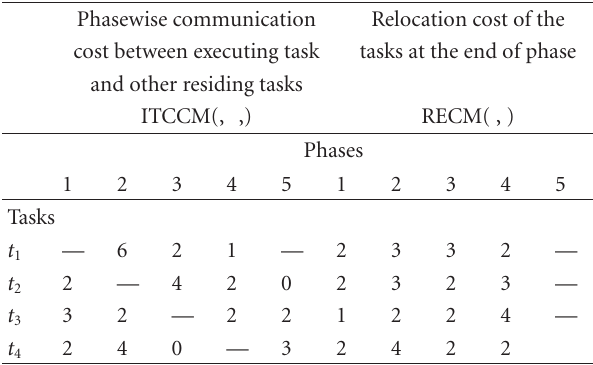
Table 2: ITCCM(, ,) and RECM( , ). Phasewise